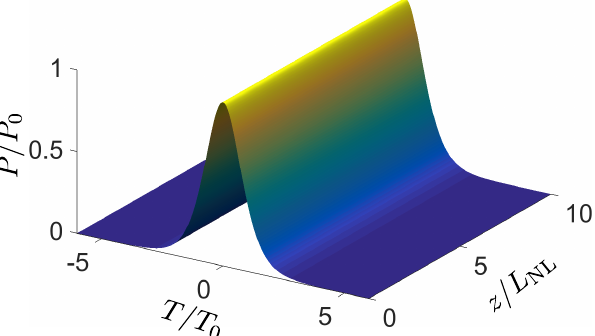
Figure 1. Evolution of a fundamental nonlinear Schrödinger equation (NLSE)